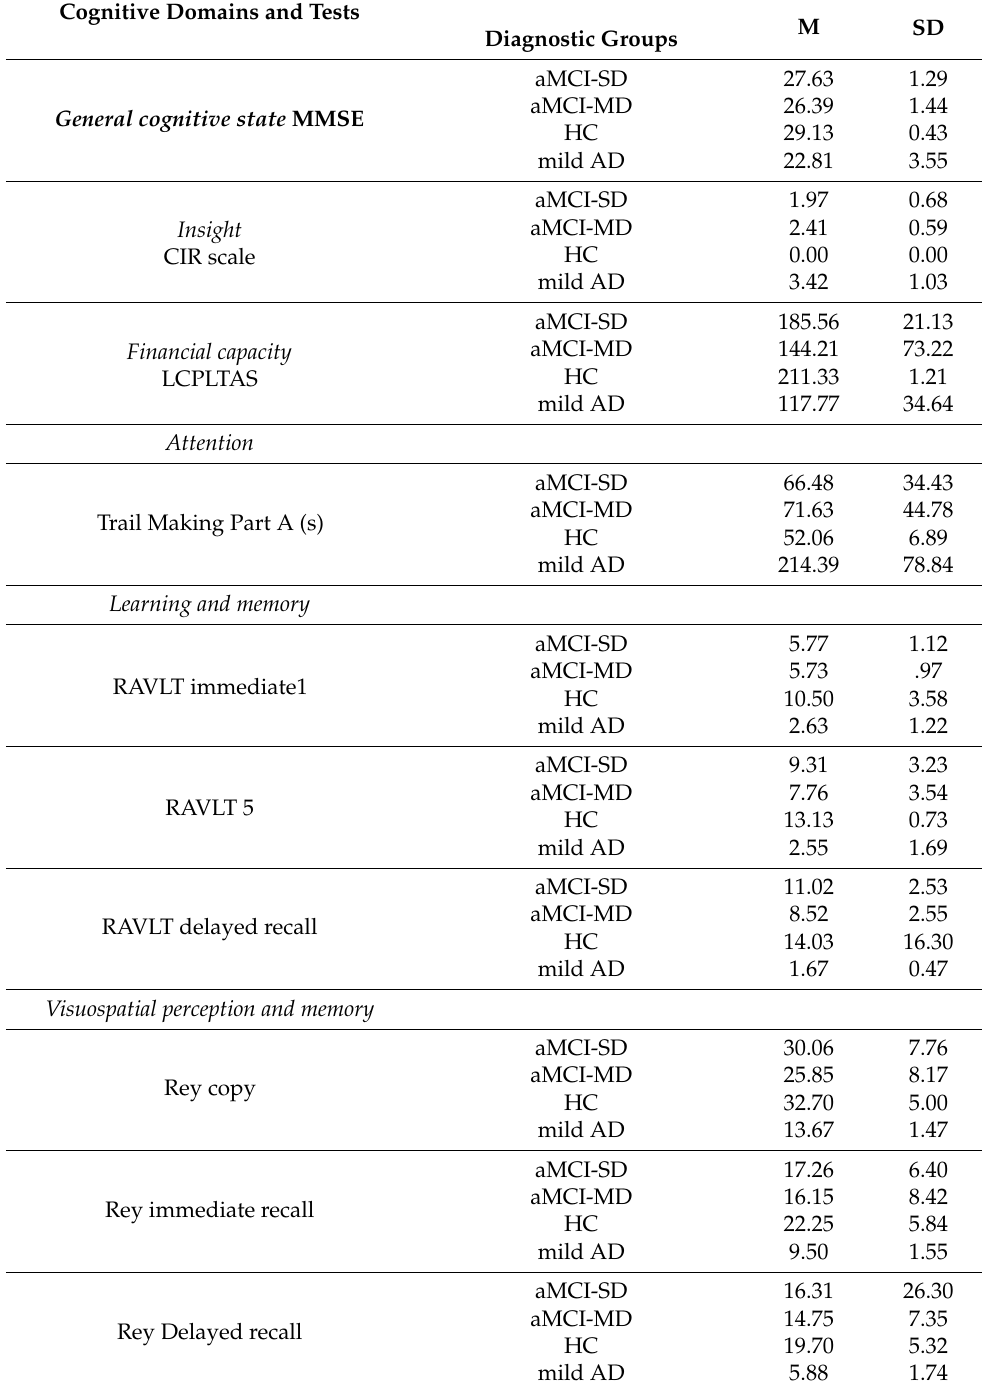
Table 1. Mean (M) and standard deviation (SD) for raw scores of the administered neuropsychological tests and for self-estimations for each cognitive domain across diagnostic groups. Cognitive Domains and Tests M SD Diagnostic Groups